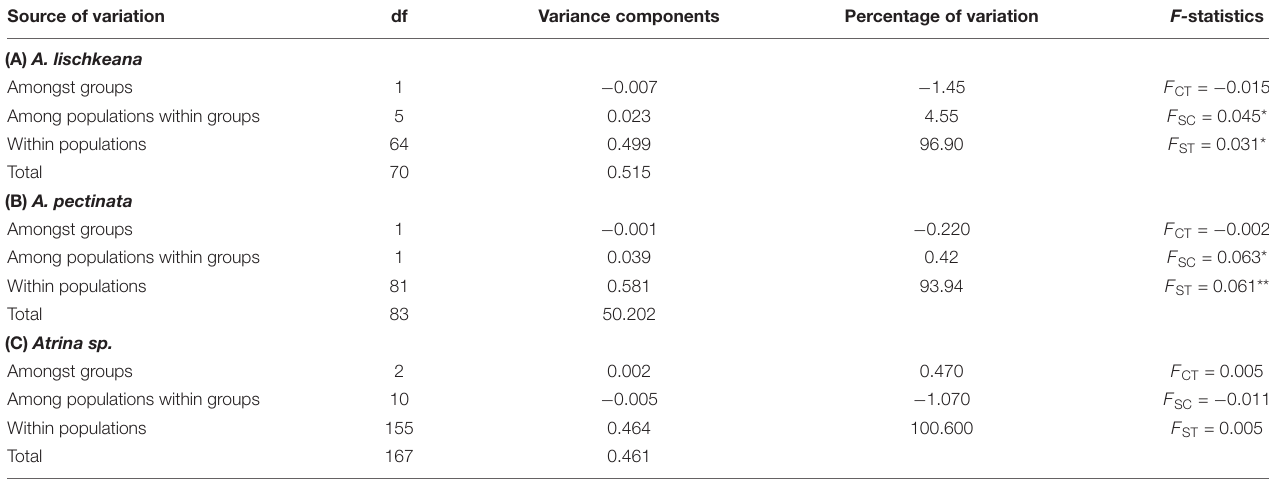
TABLE 4 | Analysis of molecular variance (AMOVA) based on mt COI datasets. Source of variation df Variance components Percentage of